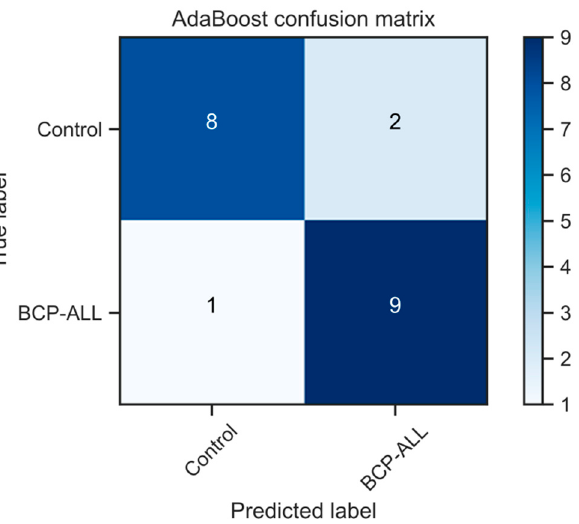
Figure 4. Confusion matrix of an AdaBoost prediction model based on principal components of the first derivative spectra. This model achieves an 85% accuracy as assessed by leave-one-out